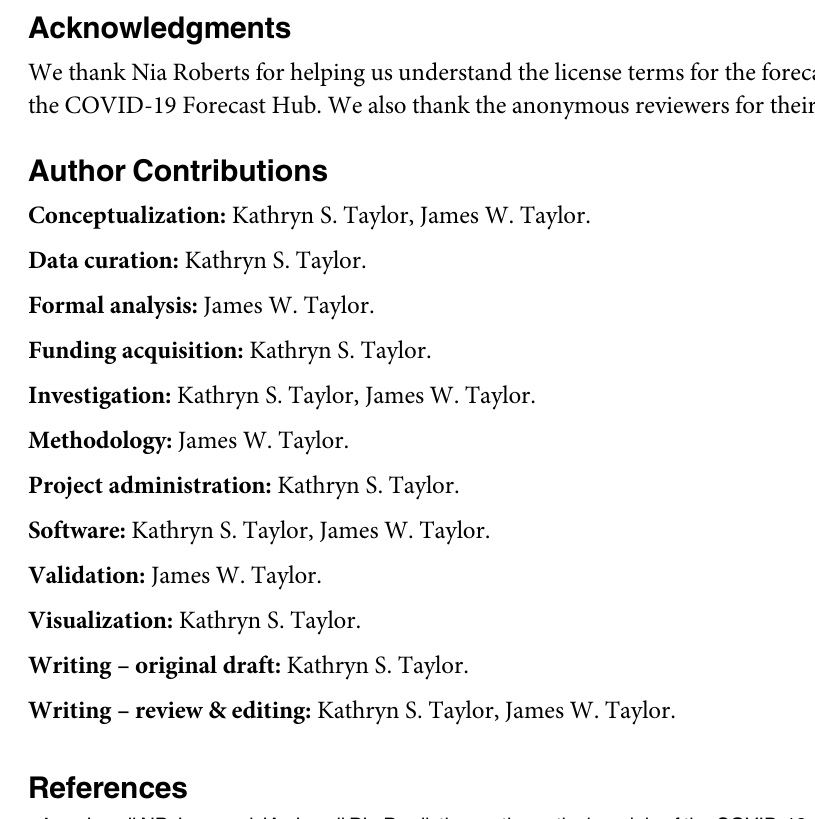
S15 Table. Sensitivity analysis for cumulative mortality, skill scores of the 95% interval MIS and MWIS after excluding locations for which there were noticeable changes in reporting patterns. Shows percentages. Higher values are better. a best method in each col-